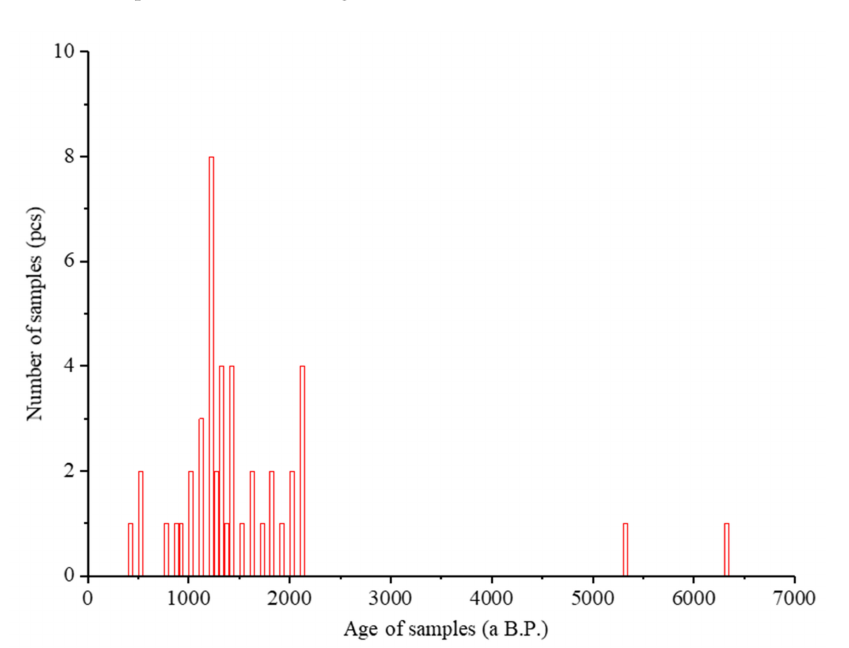
Figure 10. Frequency histogram of OSL dating